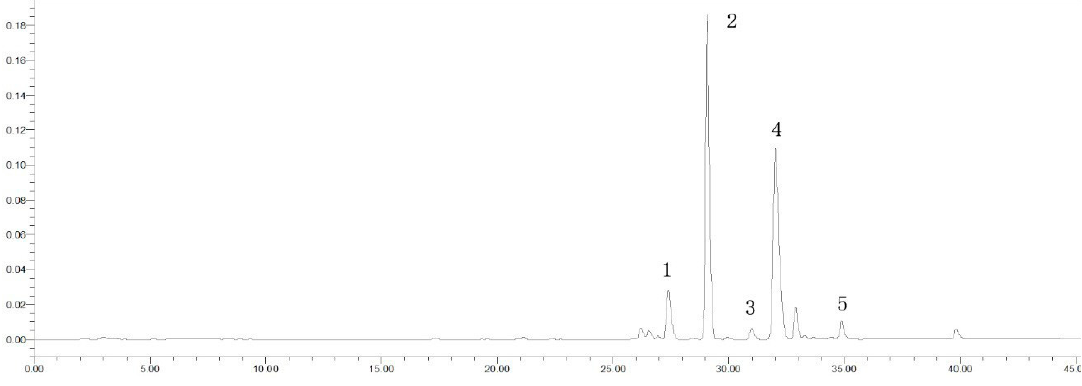
Figure 2. The HPLC chromatogram of SB-CC CFP. The numbers 1 to 5 represent five major chemical constituents.